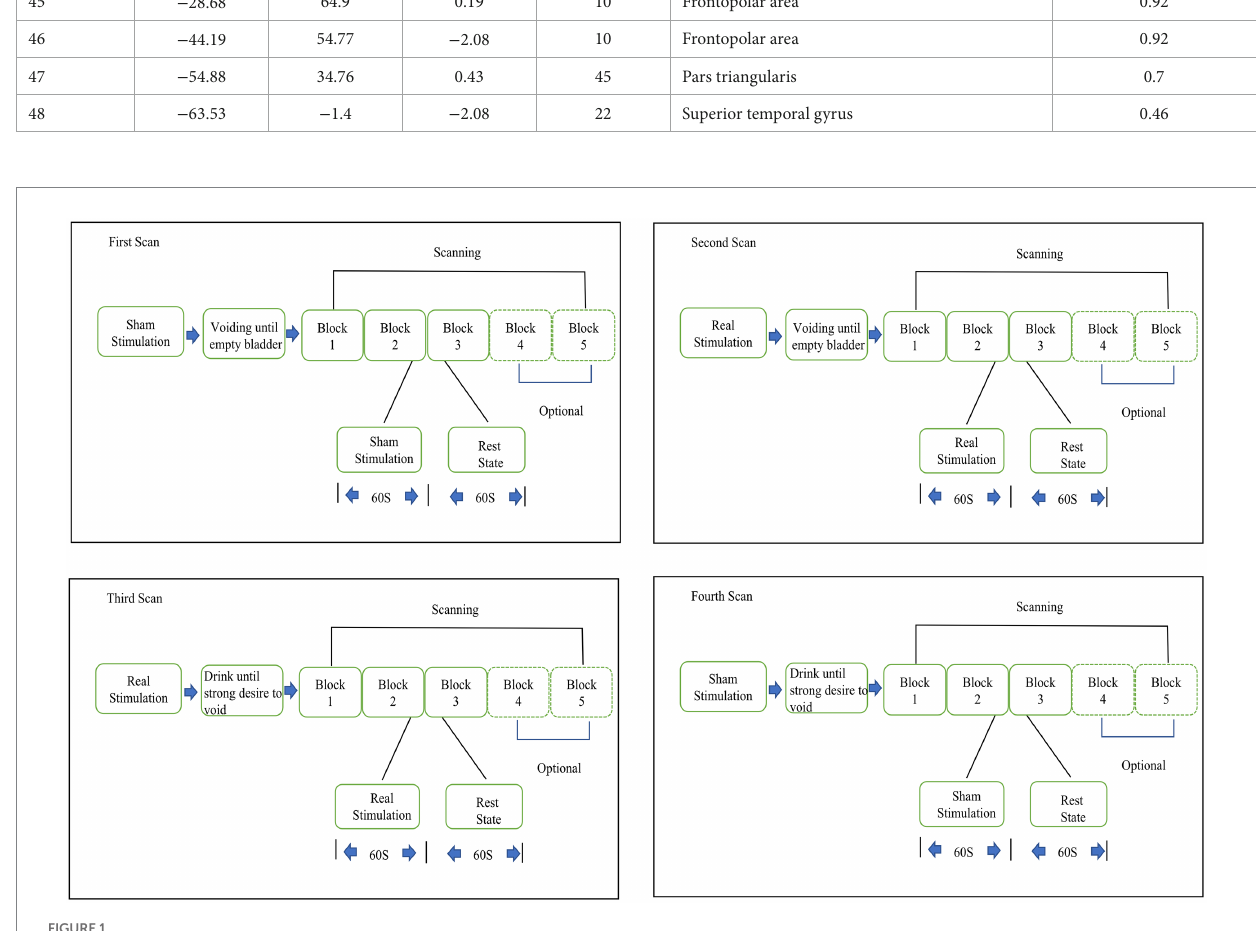
FIGURE 1 Block diagram of the fNIRS experimental